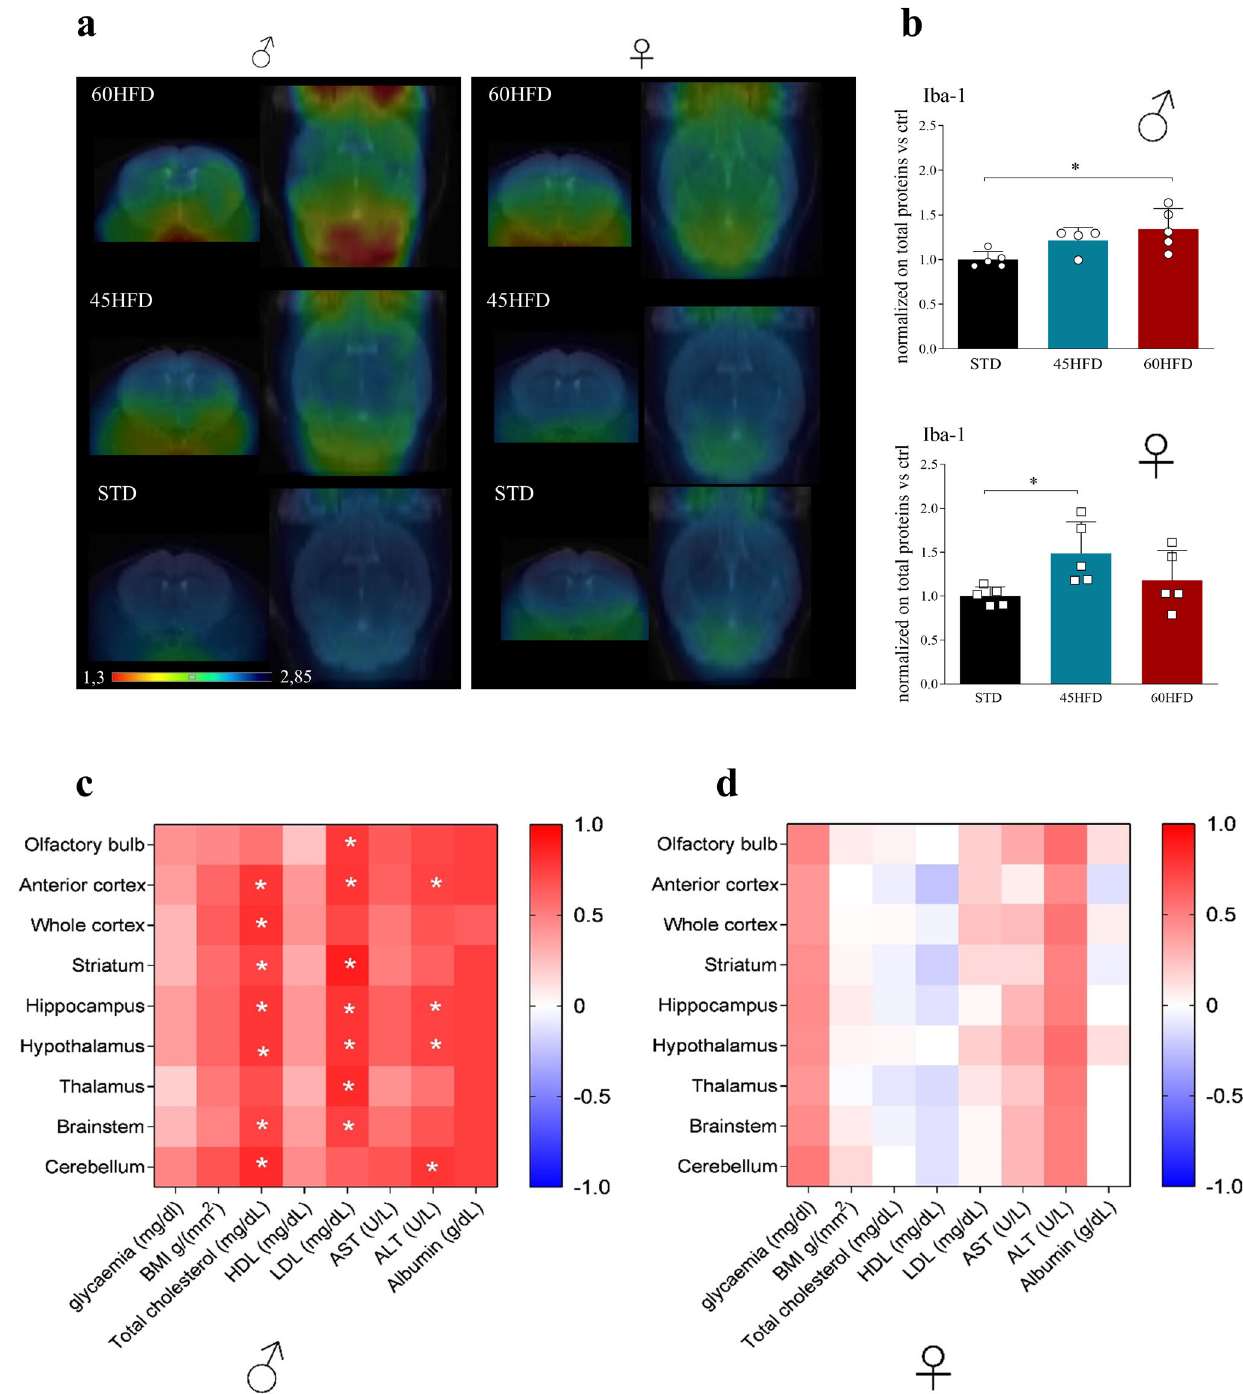
Fig. 4 Brain neuroin fl ammation after HFD regimen. a Representative panel of [ 18 F]-VC701 tracer brain uptake in male (left) and female (right) mice of all groups (STD, 45% HFD and 60% HFD) after 31 weeks. PET images are reported as brain to muscle ratio. b Western blot quanti fi cation of Iba-1 protein in male and female anterior cortex at 35 weeks of diet. Data, normalized on total proteins, are analyzed using Kruskal – Wallis test followed by Dunn ’ s post hoc test and are expressed as mean ± S.E.M. vs STD (* p ≤ 0.05). c , d Heat maps of Spearman ’ s r correlation coef fi cients between [ 18 F]-VC701 brain uptake and basal glycemia, BMI, and serum level parameters at 31 weeks of diet in male ( c ) and female ( d ) mice. The pseudocolor bars represent the values ranging from − 1 (blue, negative correlation) to + 1 (red, positive correlation). The white asterisks represent correlations that are statistically signi fi cant ( *p ≤